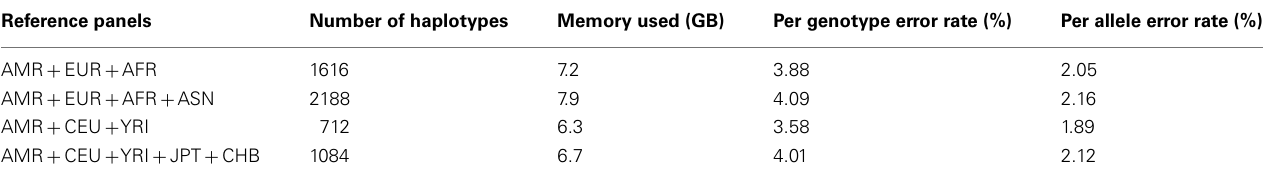
TableA3 | Genotype imputation accuracy for chromosome 19 based on the 1000 Genomes Project reference panels. Reference